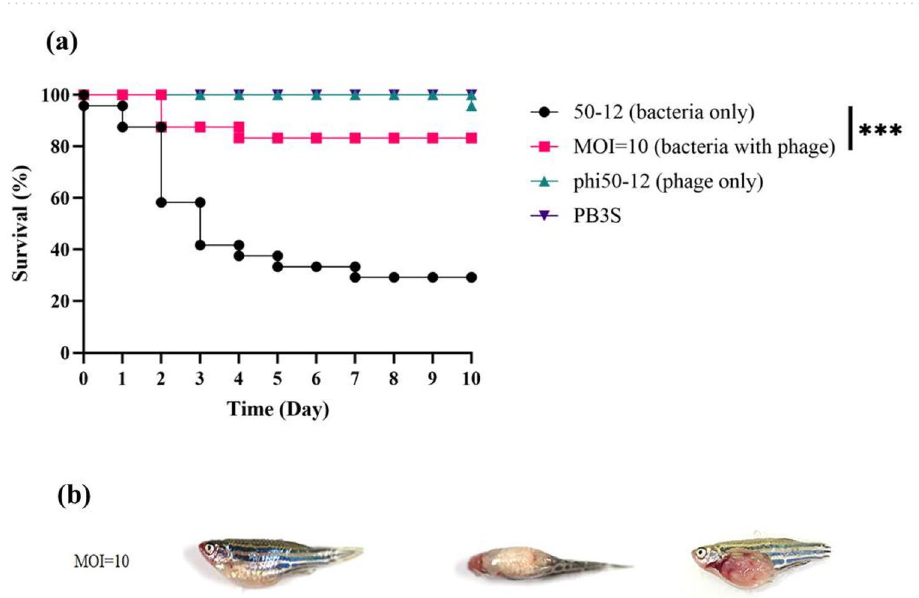
Figure 8. Therapeutic effect of phi50-12 in zebrafish. ( a ) Four groups were considered, each containing 24 fishes. These were subjected to four distinct conditions: injection with V. owensii GRA50-12 cells (2.8– 4.5 × 10 6 CFU/20 µl, black line), phi50-12 treatment (MOI = 10) for 30 min followed by challenge with bacteria (red line), phi50-12 treatment only (green line) and PB3S buffer as negative control (purple line); and survival rates were measured. The X-axis represents the time post-infection and the Y-axis represents the survival percentage of the zebra fish. ( b ) The disease symptoms of zebrafish rescued by phi50-12 with MOI = 10. V. owensii GRA50-12 introduced first in the fish followed by administration of phi50-12 after 30 min. MOI = 10 represents the disease symptom of sick fish in the group with phi50-12 administration. Left: side view; middle: top view; right: abdomen anatomy. The anatomical picture showed swollen abdomen and bleeding intestines. The significance of the differences between groups was performed by Log-rank and Gehan–Breslow–Wilcoxon test in GraphPad Prism 9. “***” indicates p <